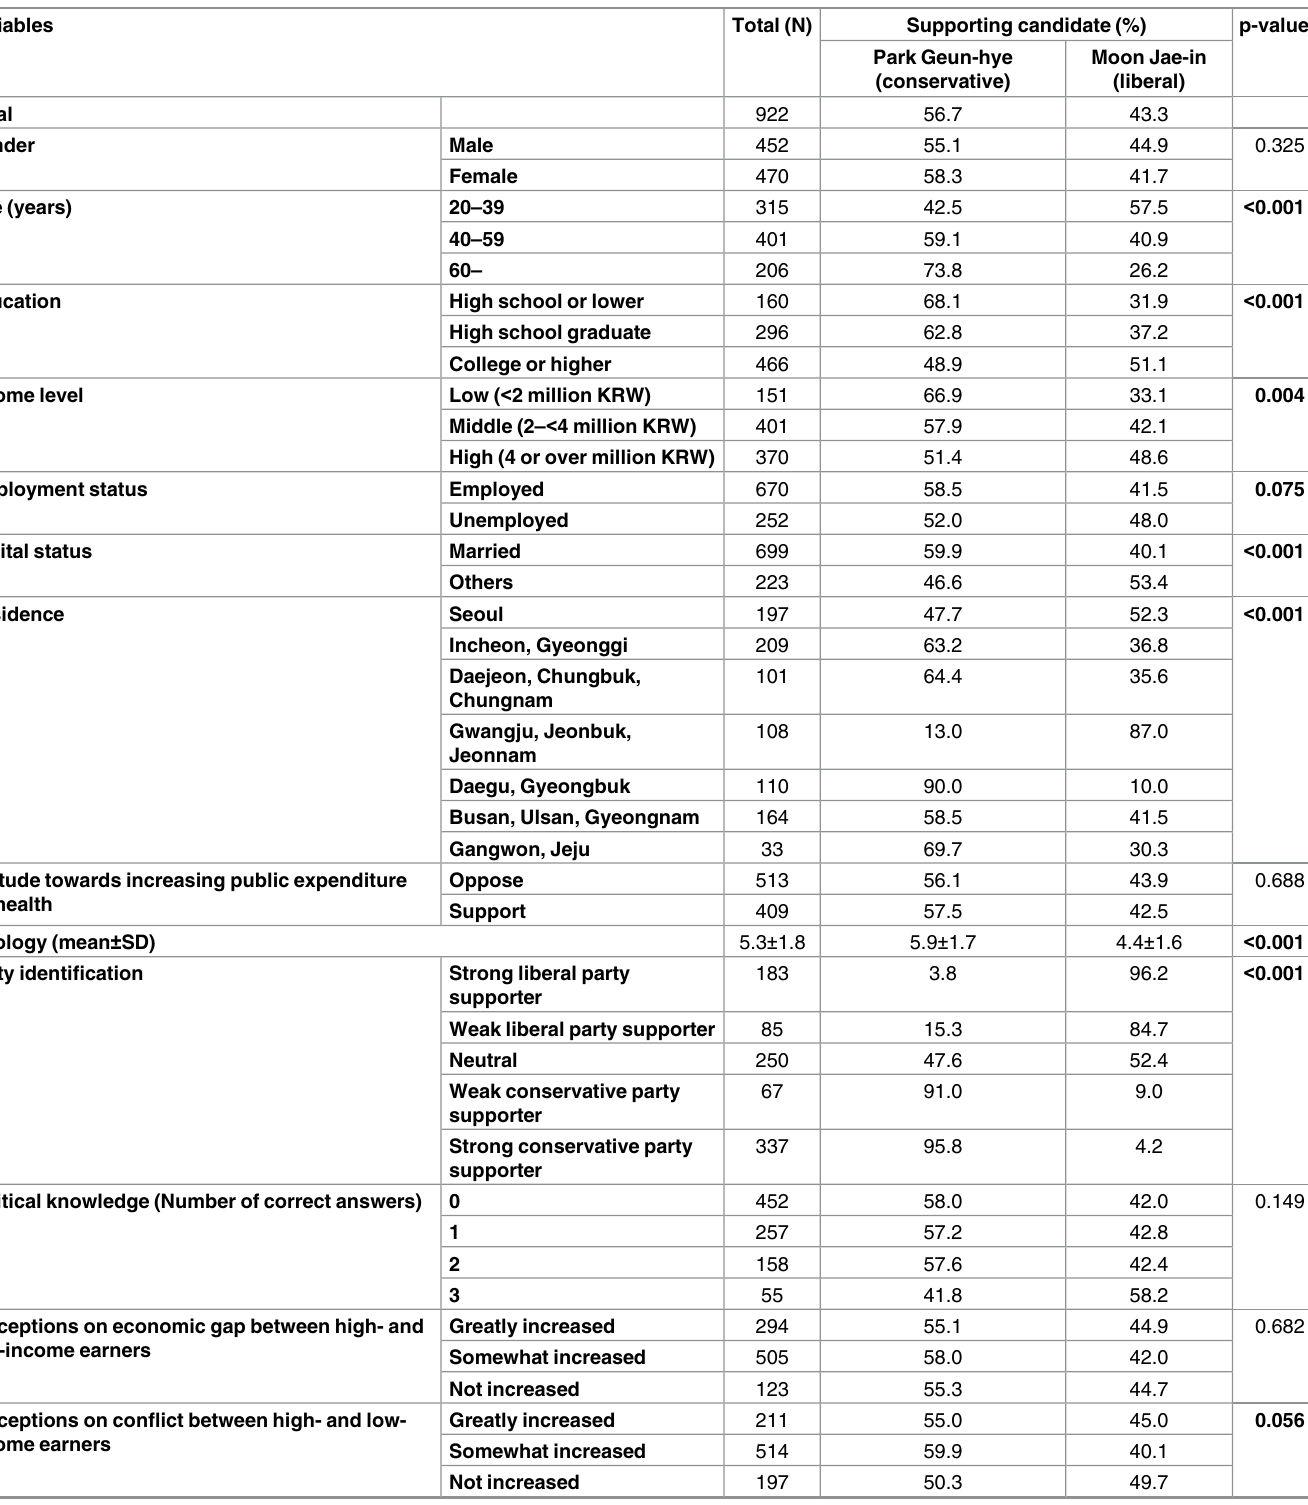
Table 1. General Characteristics of Study Population According to the Candidate Voters